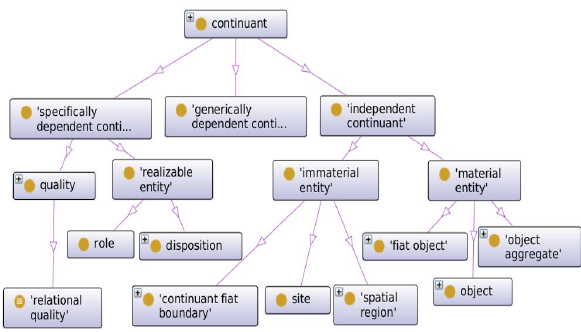
Figure 2. Hierarchy of continuants on the example of BFO Endurants include physical objects (building, road, parking, tree, lake and river). However, they can also be abstract objects